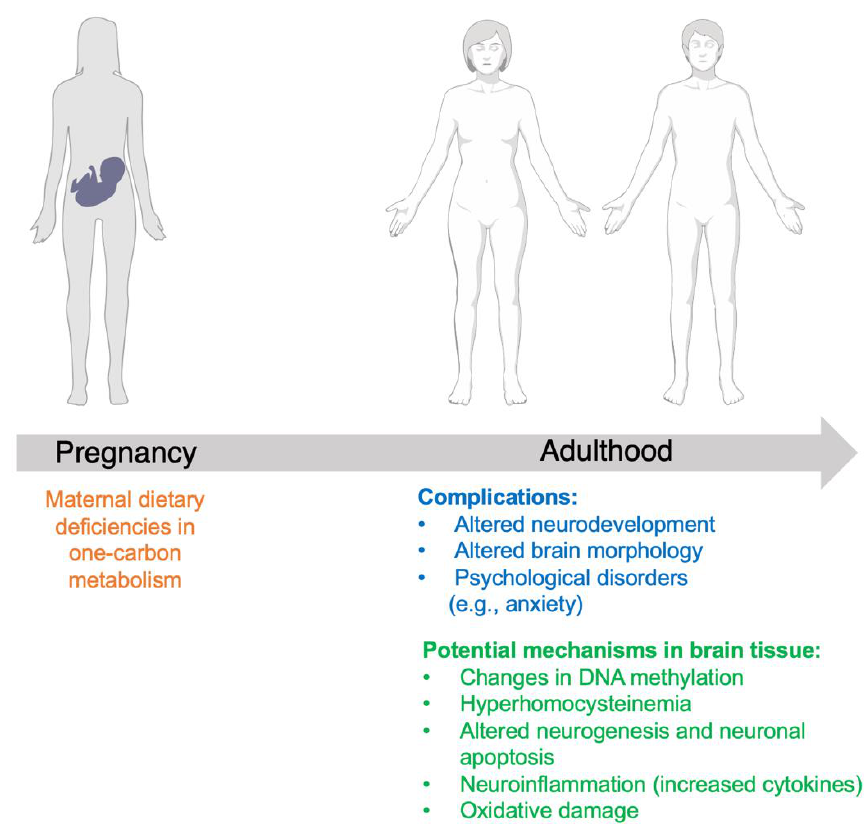
Figure 2. Summary of complications in offspring secondary to maternal dietary folate deficiency, and potential mechanisms of folate in neurodevelopment.